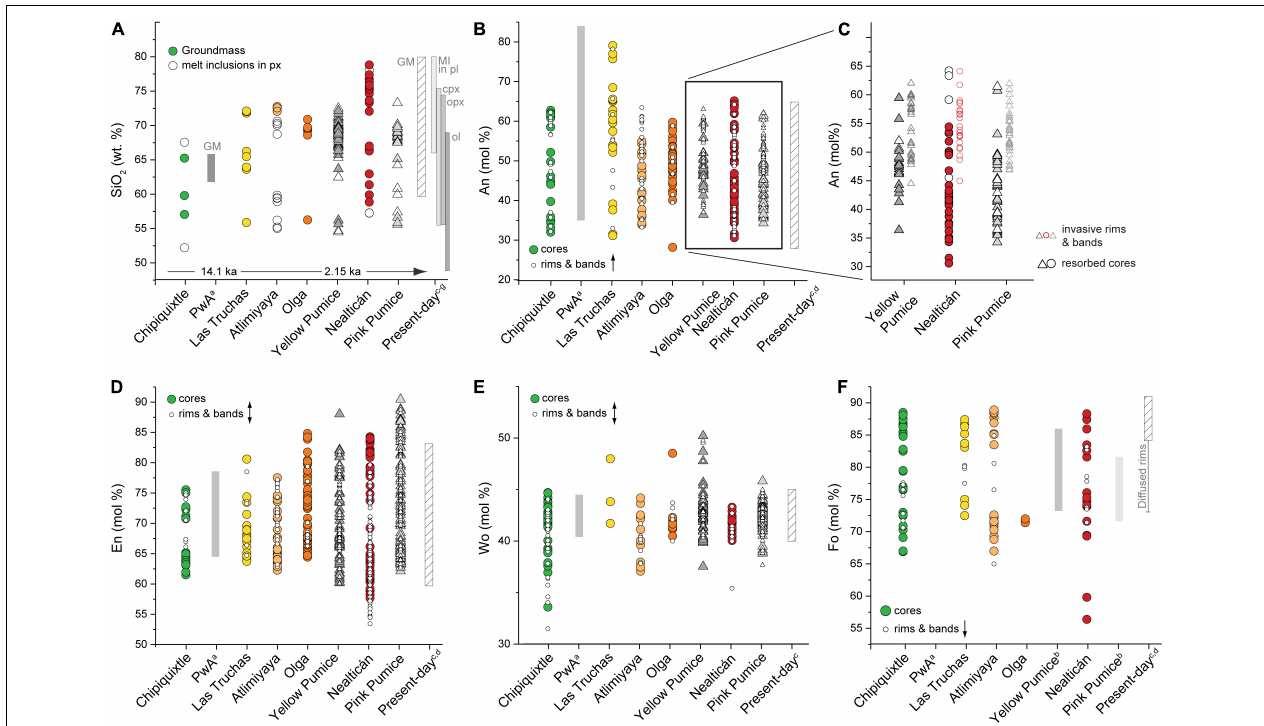
FIGURE 3 | Compositional ranges of groundmass, melt inclusions and philocrysts in explosive (triangles) and effusive (circles) eruptions of the last ∼ 14.1 ka at the PVC, in chronological order. (A) Groundmass and melt inclusions. GM = Groundmass. MI = Melt inclusion. Filled symbols = groundmass measurements. Hollow symbols = melt inclusion measurements in pyroxene philocrysts. (B–F) Philocryst compositions. Filled symbols = core measurements. Hollow symbols = bands and rims. Arrows indicate dominant direction of zoning; upward = reverse; downward = normal; double = both reverse and normal. (B) Plagioclase. (C) Detailed view of plagioclase cores and invasive bands and rims in Yellow Pumice, Nealticán and Pink Pumice. White symbols = resorbed cores. (D) Orthopyroxene. (E) Clinopyroxene. (F) Olivine. Literature data: a – Sosa-Ceballos et al., 2012; b – Schaaf et al. (2005); c – Witter et al., 2005; d – Straub and Martín-Del Pozzo,